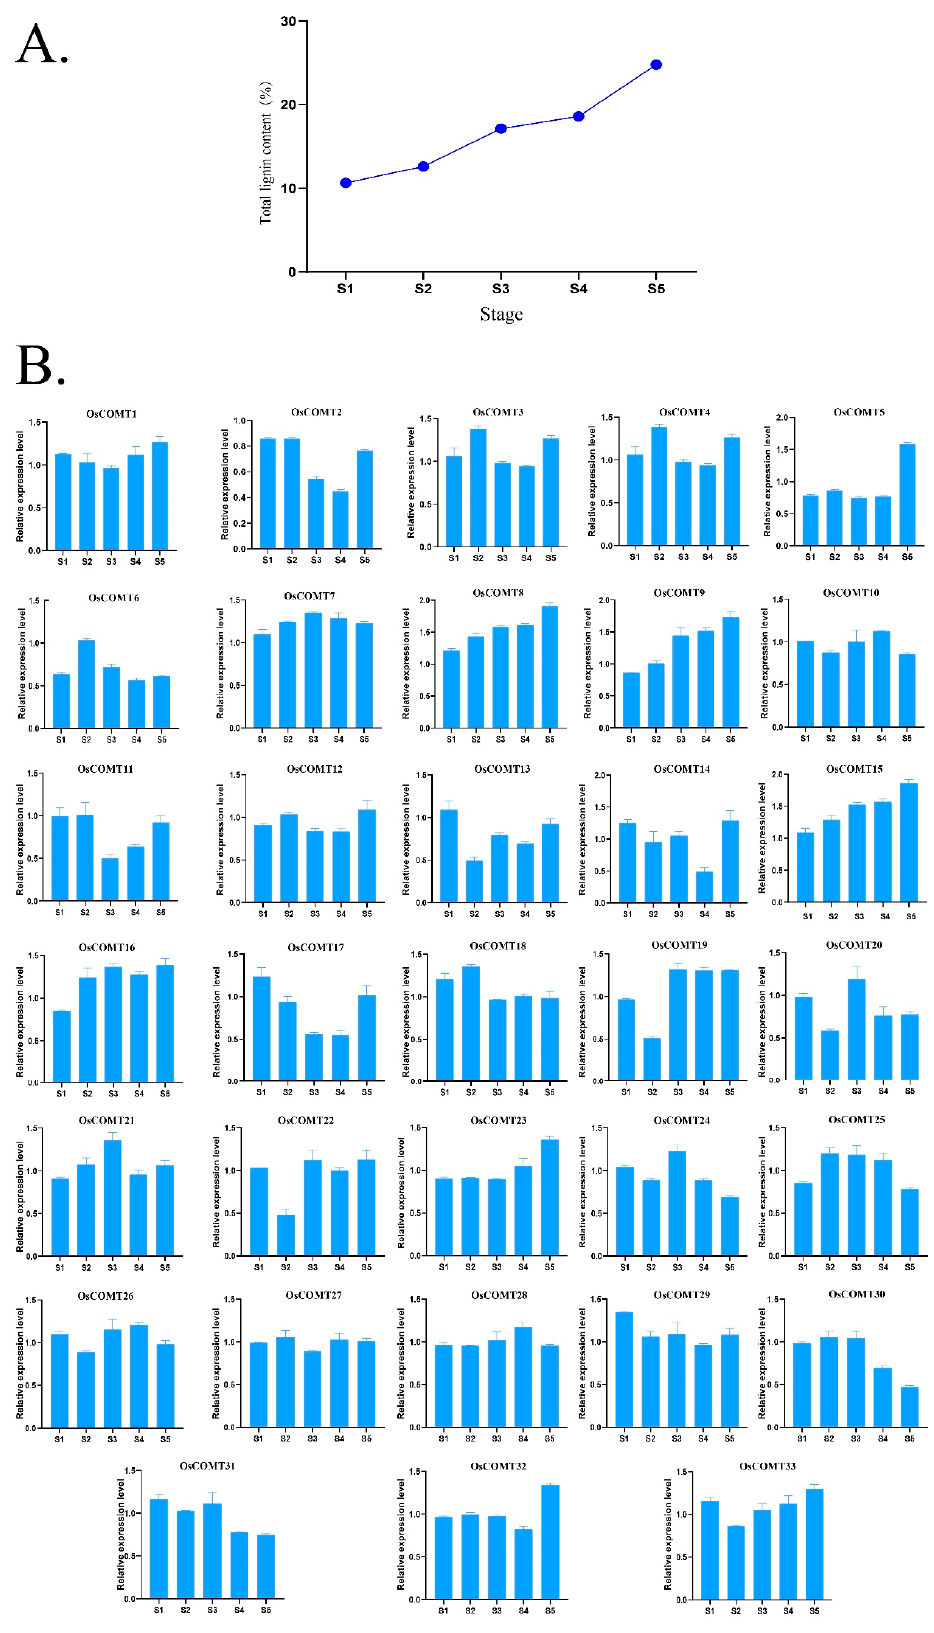
Figure 7. ( A ) Lignin content in five growth stages of rice stem. ( B ) Expression of OsCOMTs in rice stem at five different stages. S1: Seedling stage, S2: Tillering stage, S3: Booting stage, S4: Heading stage, S5: Filling